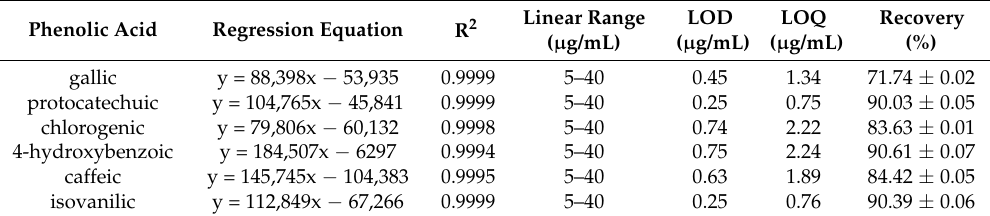
Table 1. Regression data, LODs, LOQs, and recovery for studied